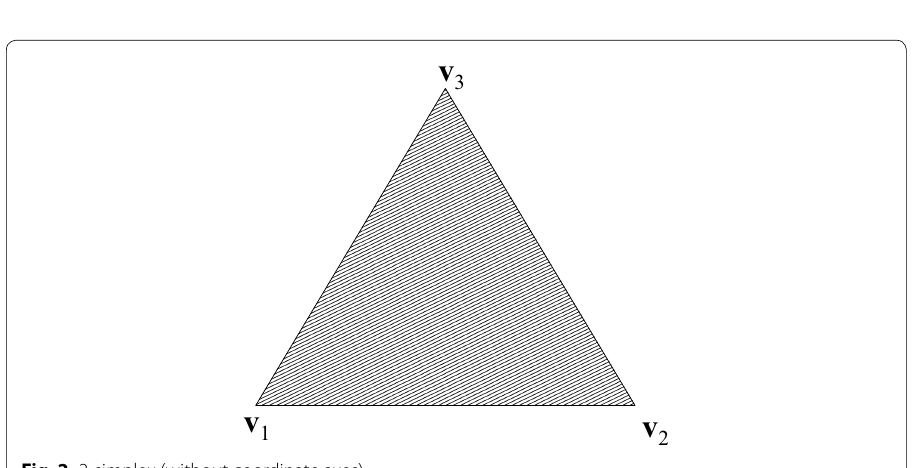
Fig. 2 2-simplex (without coordinate